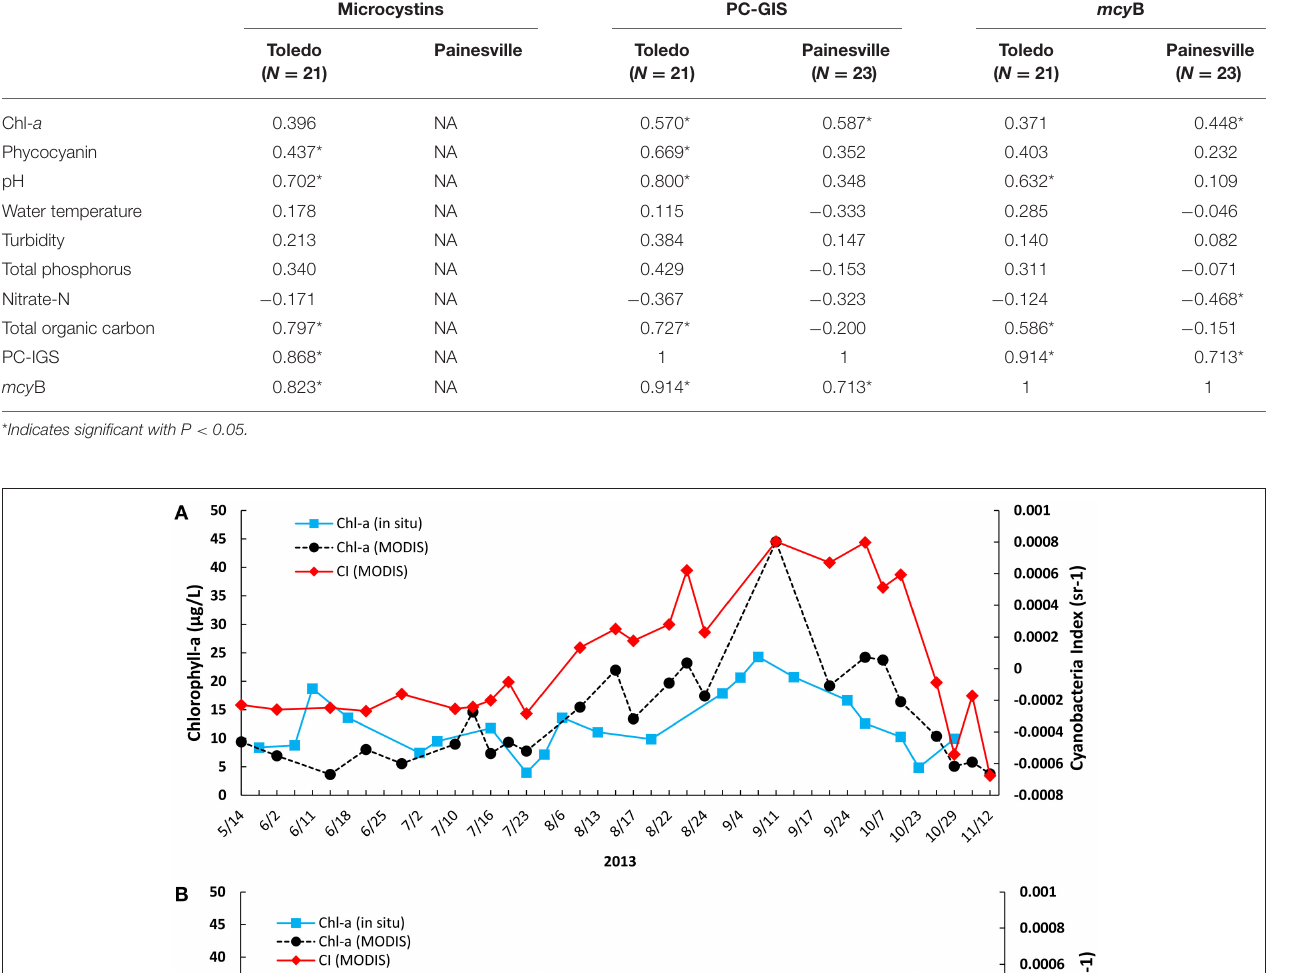
concentration of chlorophyll- a ( R 2 = 0.5319, P < 0.05)